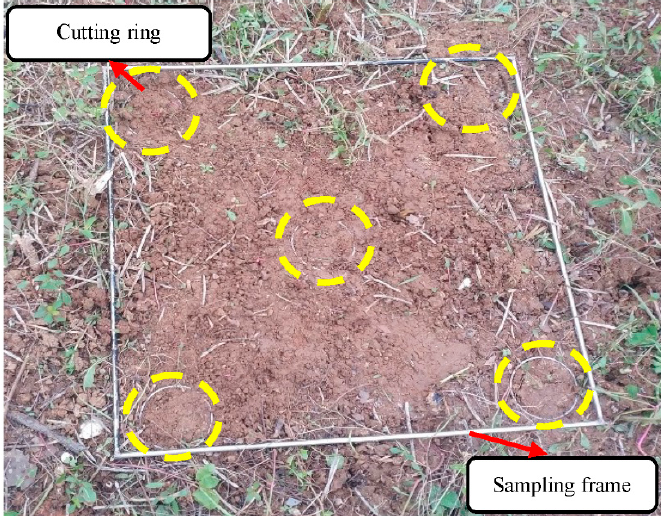
Figure 1. Five-point sampling method. Table 1. Basic physical characteristics of soil samples.